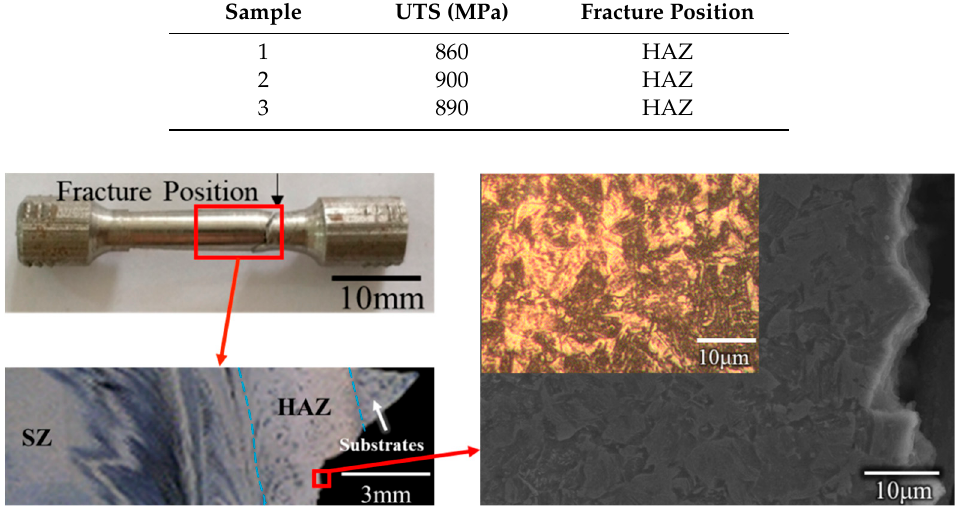
Figure 10. Image of the fracture position in the tensile specimens.